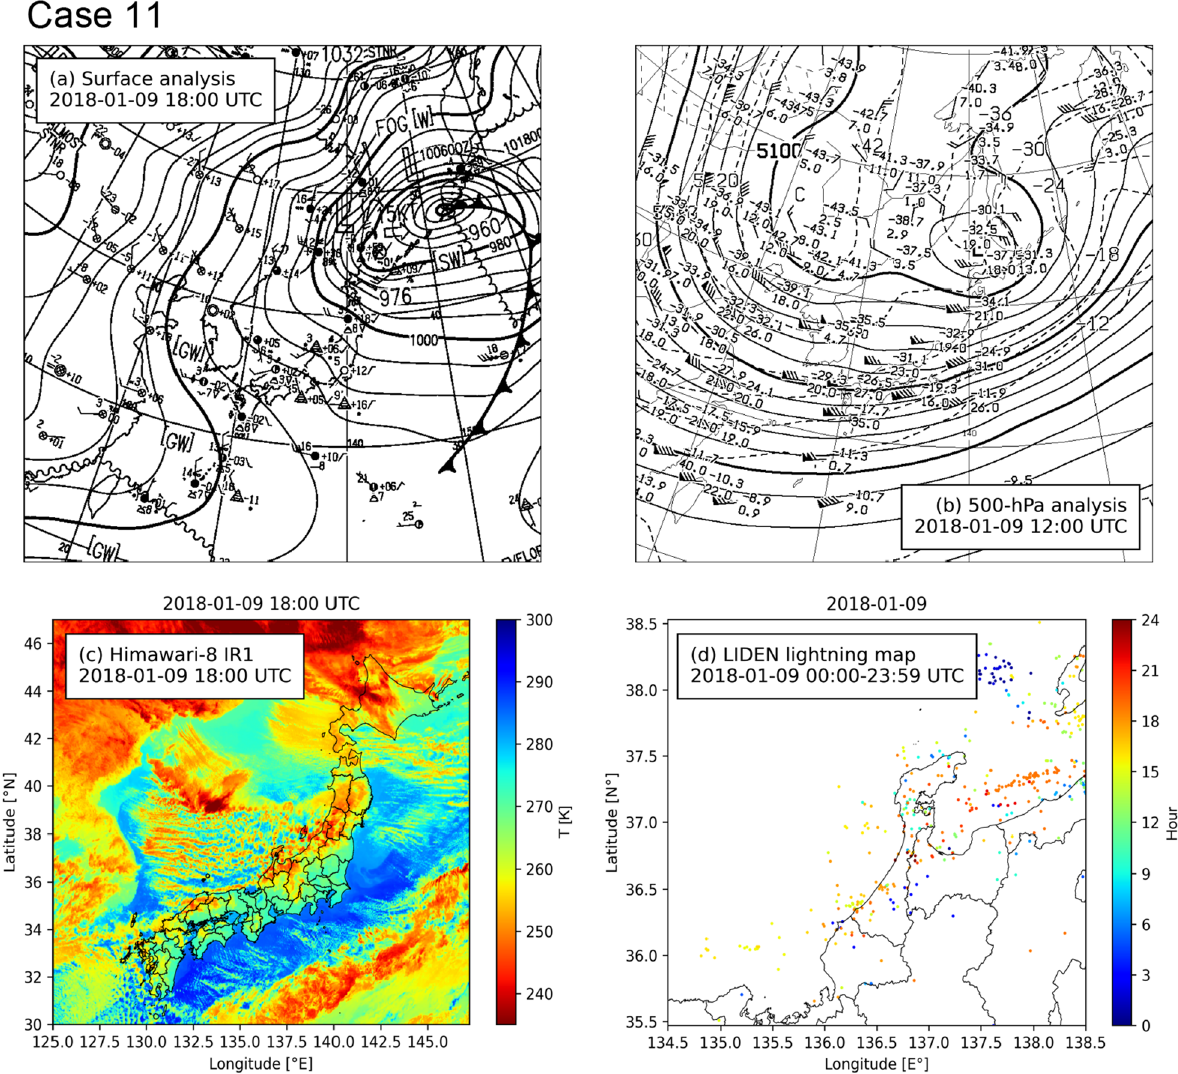
Fig. 2 Meteorological charts of the glow-detection Case 11. a An expanded view of JMA surface analysis (ASAS). b An expanded view of JMA 500 hPa analysis (AUPQ35). c Brightness-temperature heat map taken by Himawari-8 Advanced Himawari Imager IR1 (band 13). d Daily lightning map based on the LIDEN